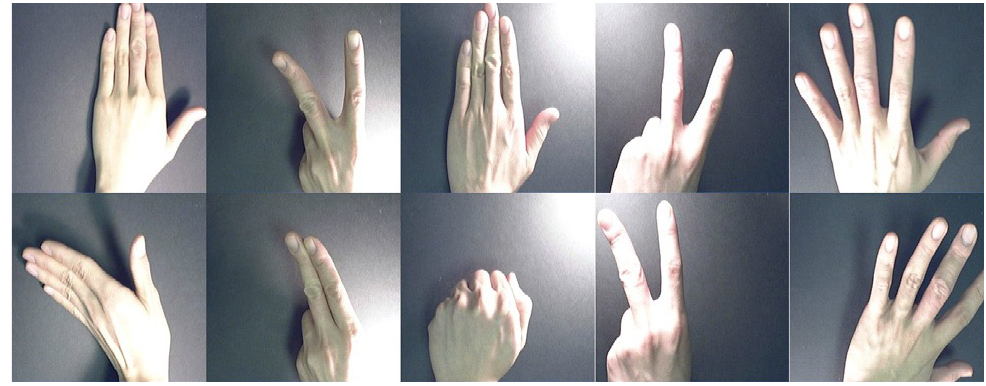
Figure 2. Sample frames of hand gesture from Cambridge-Gesture dataset.